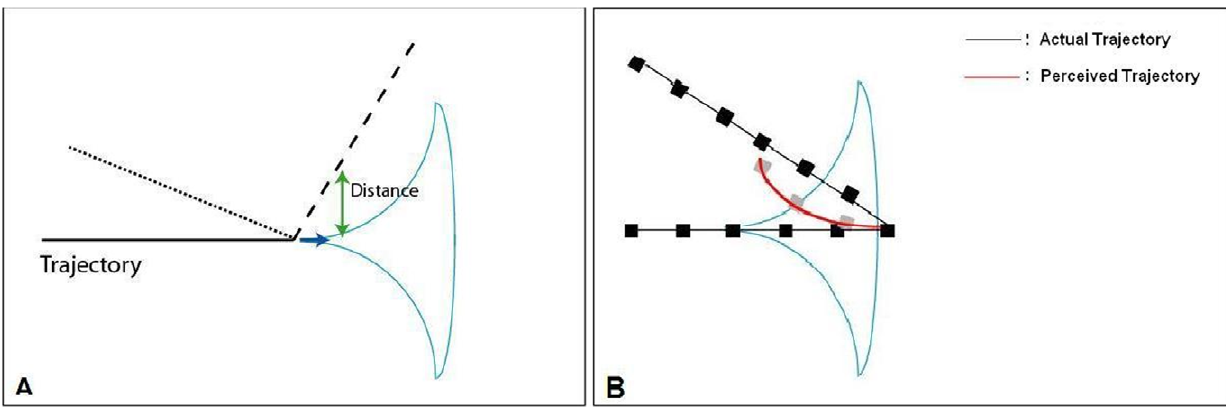
Figure 2. Trajectories and their misperceptions. A. Trajectories for two angles of deviation are shown. The solid line is the initial portion of the trajectory, the dashed line represents a 67 deg deviation and the dotted line represents a 157 deg deviation. Motion anticipation is shown as a cone. Its influence is dependent on the distance to the axis of motion after deviation. B. The proposed influence of motion-anticipation on the perceived trajectory for angles larger than 90 deg. The black squares represent a path of apparent motion for the moving dot undergoing deviation (black line). The persisting motion-anticipation due to the previous horizontal motion (cone) presumably shifts the perceived positions of the dot closer to the axis of motion resulting in the trajectory shown by the gray dots and red curve. Any shift in the perceived position of the dots would cause the trajectory to appear curved (sharpened). results obtained. Each trajectory consisted of a square dot of side 4 arcmin and luminance 50 cd/m 2 moving from left to right at a speed of 9.4 deg/sec against a background of 5 cd/m 2 . The direction of motion for the first half of the trajectory varied between trials according to the deviation angle, while that for the second half was always 45 deg from the horizontal (Figure 3A solid black line). The deviation in the trajectory occurred at the center of the screen, after the dot had moved 7.1 deg. Fixing the direction of the second portion of the trajectory for all deviation angles normalized the distortions with respect to a common reference trajectory. Two bars of size 5.7 arcdeg 6 4 arcmin (Figure 3A thick orthogonal lines) were placed 21 arcmin below the mid-screen and 5.7 arcdeg to the right of the mid-screen to facilitate judgments of perceived curvature.